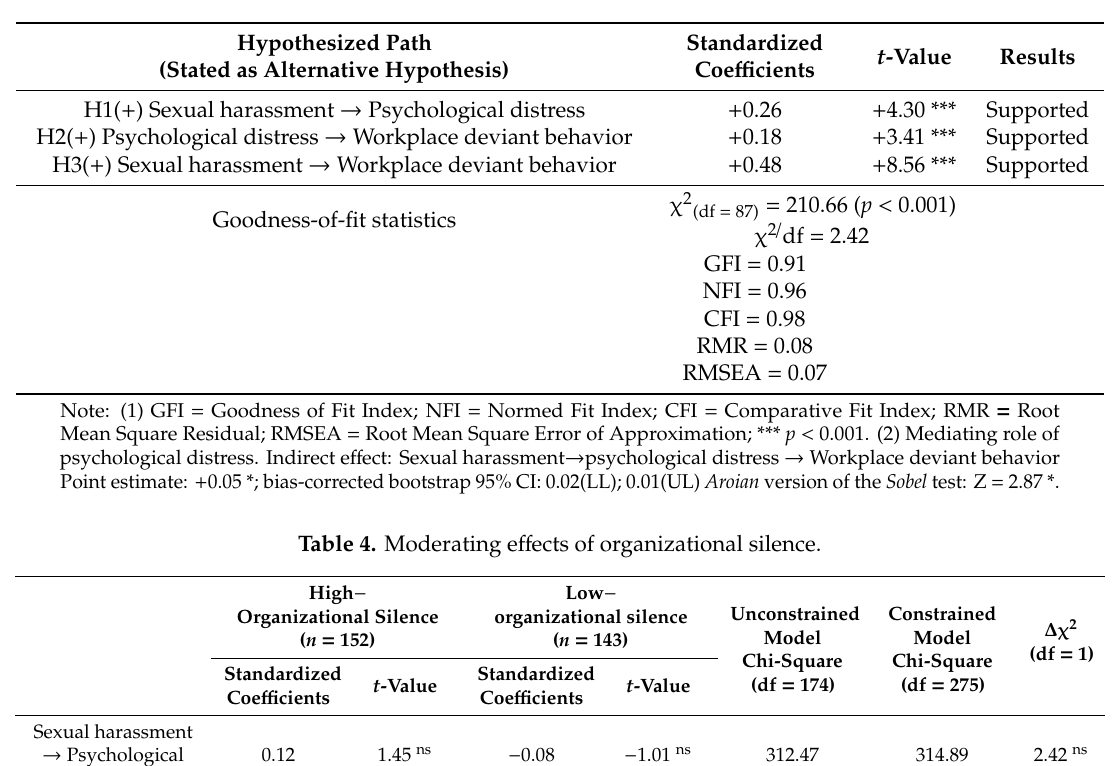
Table 3. Structural estimates model.